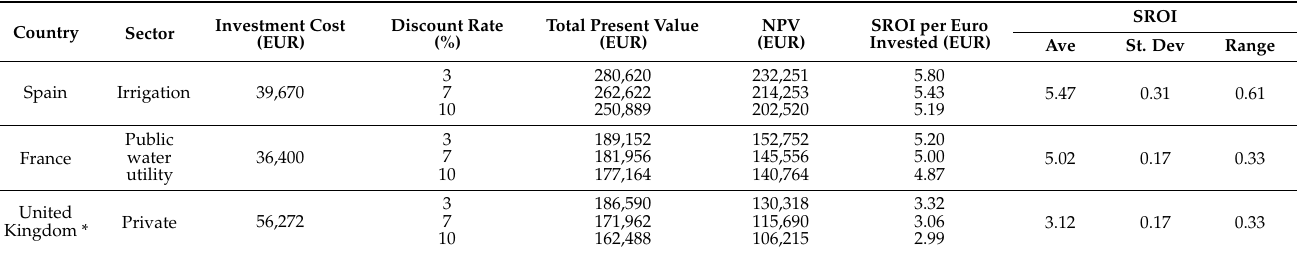
Table 8. Sensitivity of the SROI results to investment